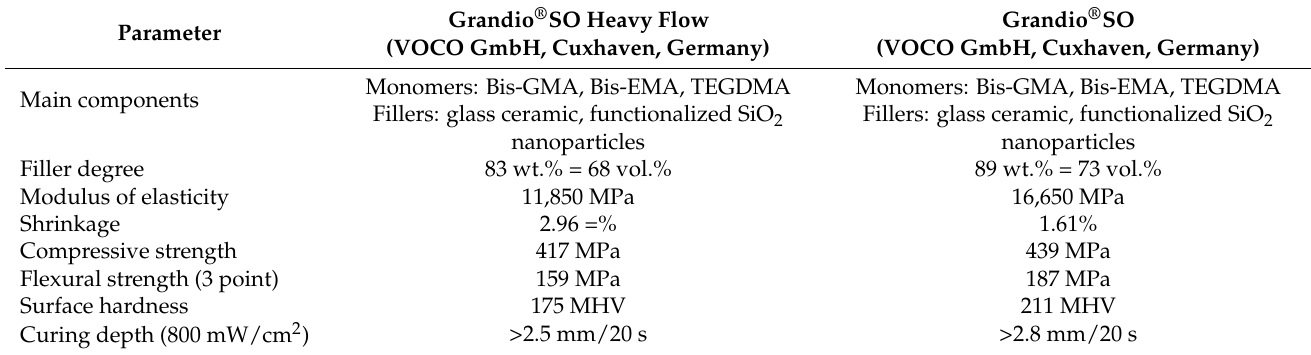
Table 1. Material properties of the composites used in this